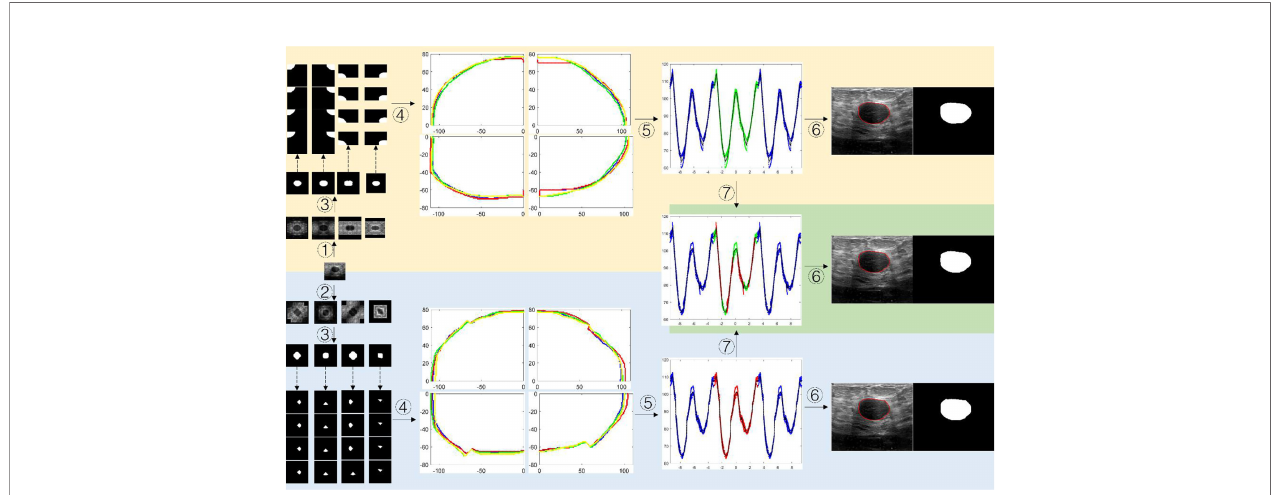
FIGURE 7 | The schematic diagram of segmented boundary reconstruction for the testing image. ① HVCMA, ② DCMA, ③ deep learning segmentation prediction from model 1 or mode 2, ④ extracting the tumor boundaries and mapping them to the original image coordinates, ⑤ transforming the rectangular coordinates to the polar coordinates and expands the data, ⑥ transforming the boundary to the rectangular coordinate system after boundary fi tting and interception, ⑦ compensating and expanding the boundary